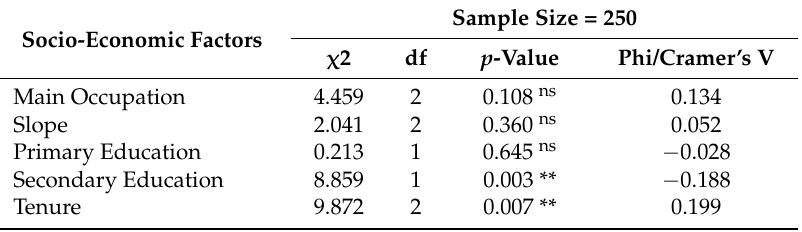
Table 3. Chi Square estimation of the association of socioeconomic variables with